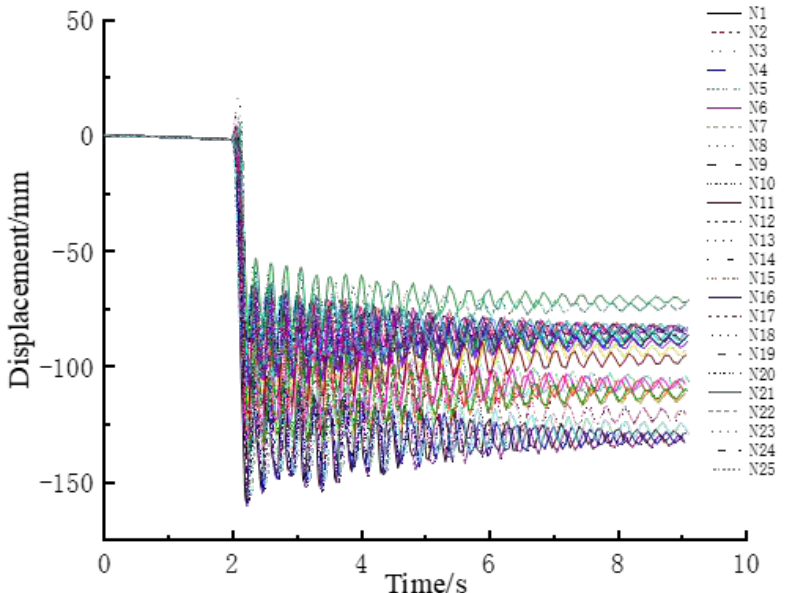
Figure 6. Vertical displacement of column top after the failure of bottom inner column. Table 3. Orthogonal test table when bottom side column fails .